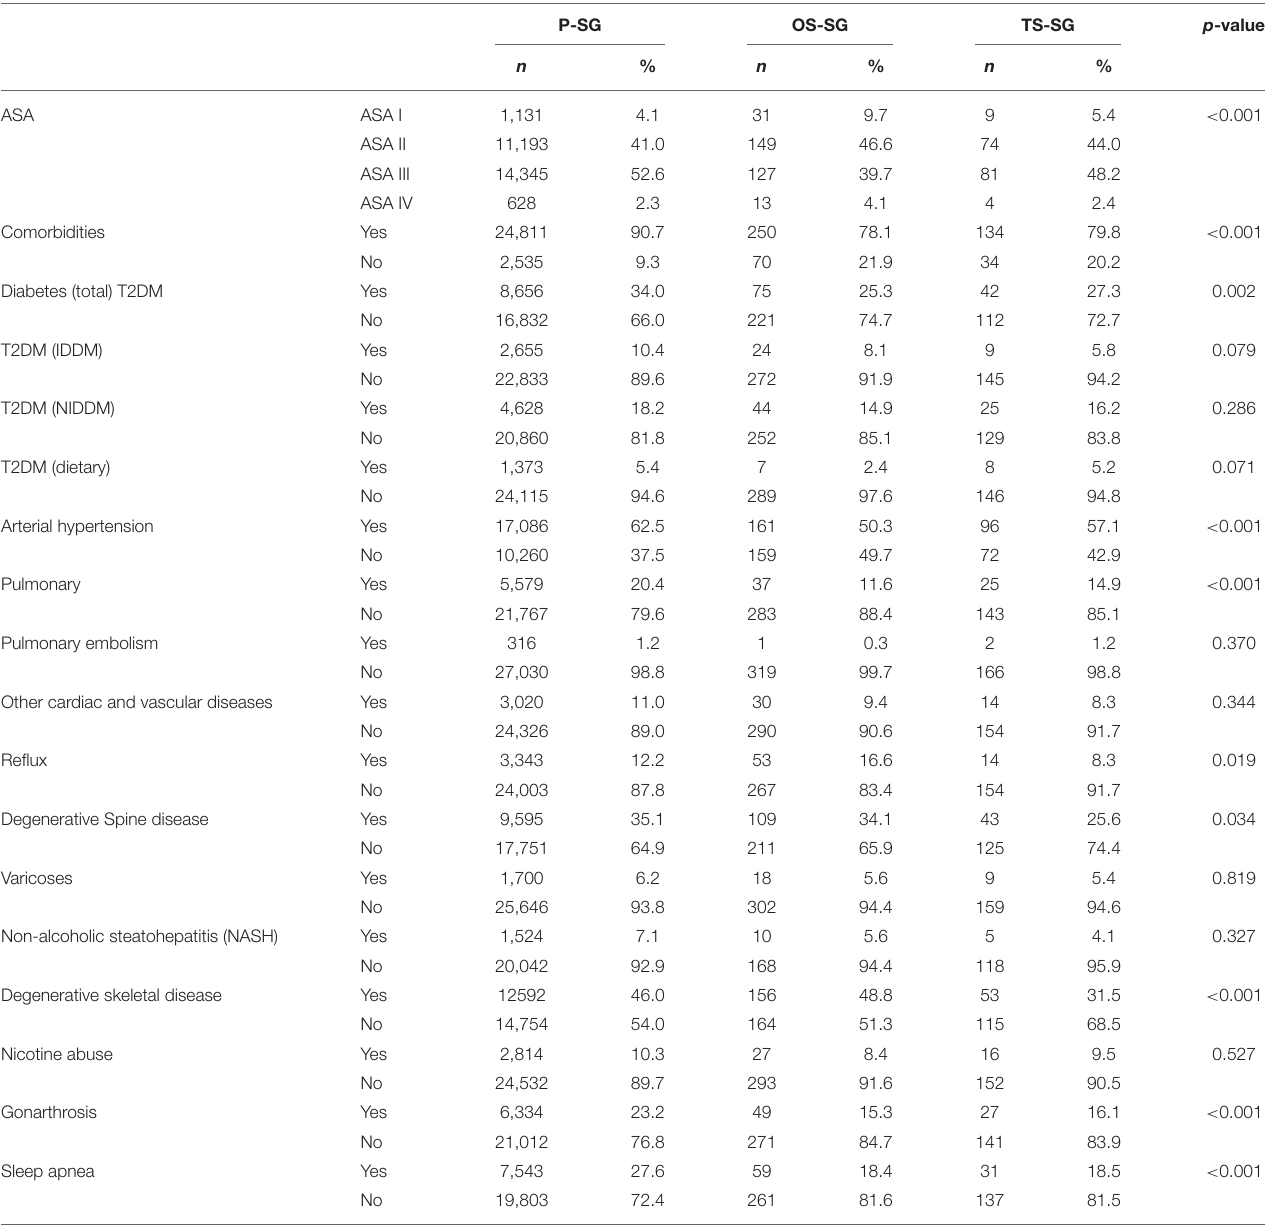
TABLE 2 | Distribution of patients according to